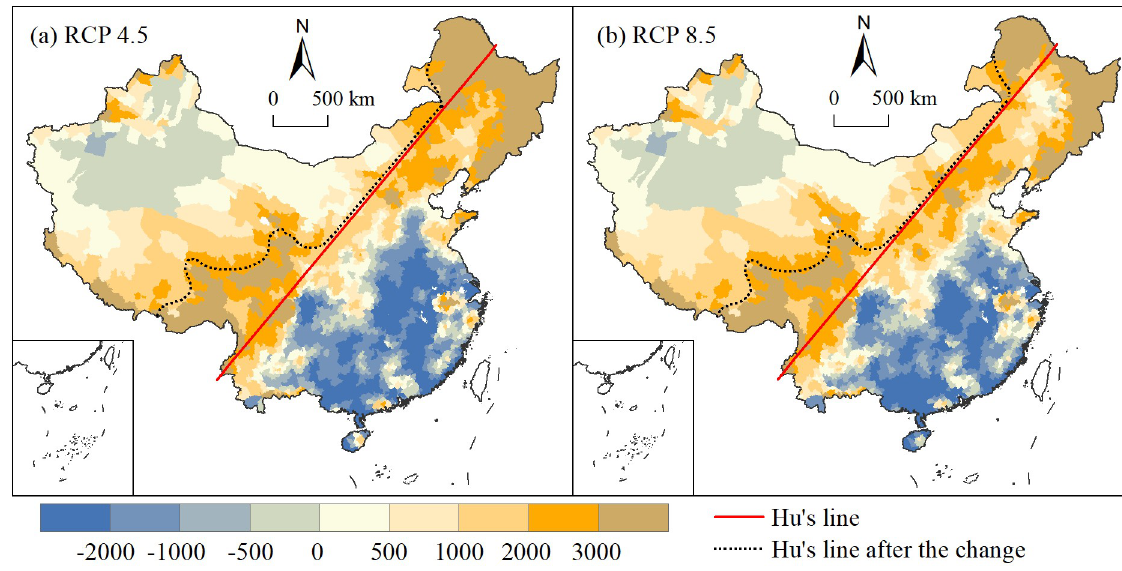
Fig 11. Changes in potential agricultural productivity and Hu’s